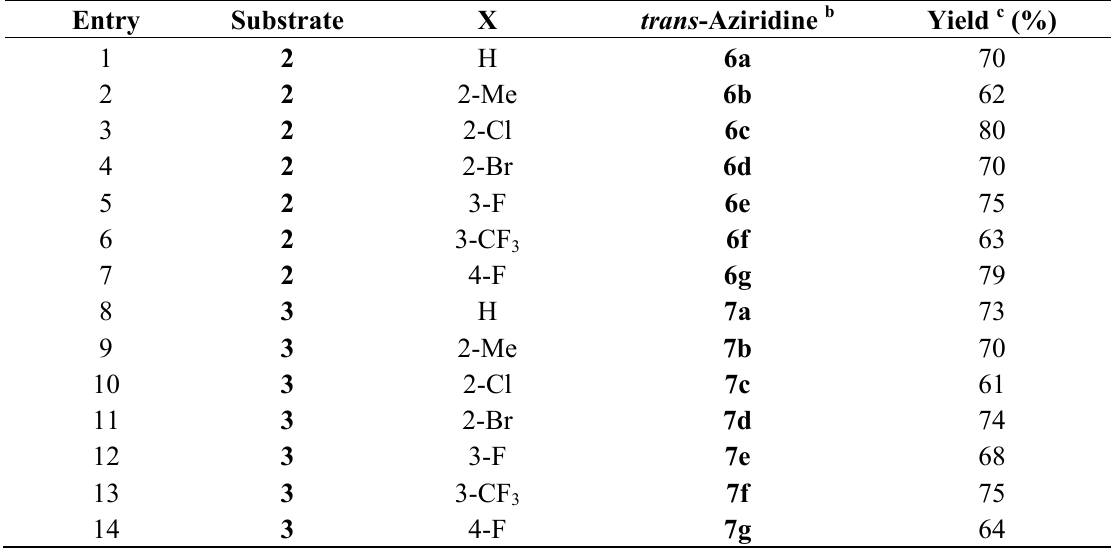
Table 2. Reaction of 1-(dichloromethyl)-2-nitrobenzene derivatives 2 – 3 with aromatic N -tosylimines 4a – g using TDAE strategy.